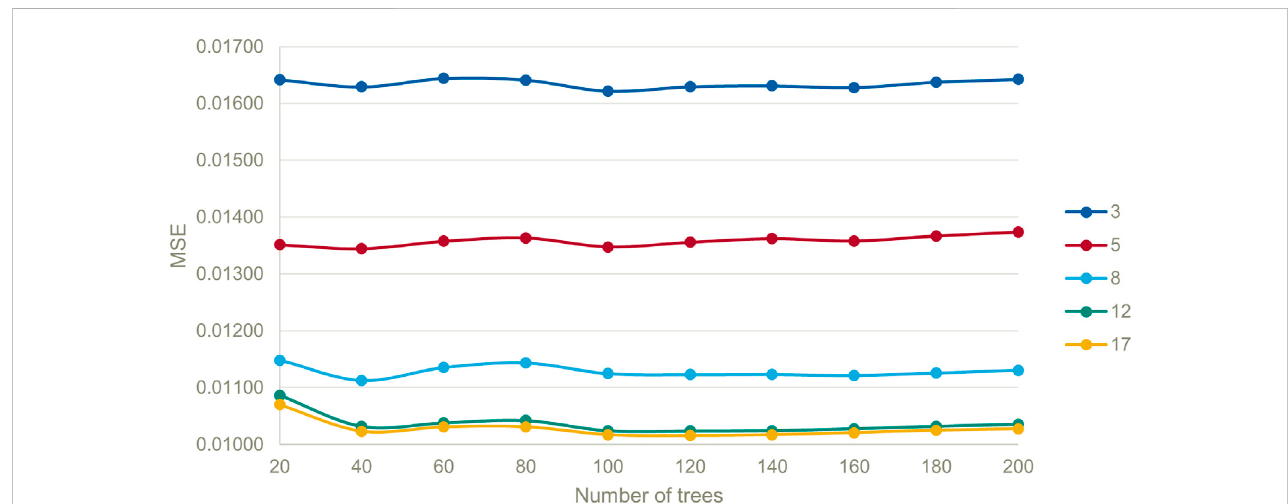
FIGURE 5 Comparisonofthemeansquarederror(MSE)inRFtrainingvsthenumberoftreesintheforestfordifferentforestdepths.Thenumberof40treesleadsto a lower MSE for all depth con fi